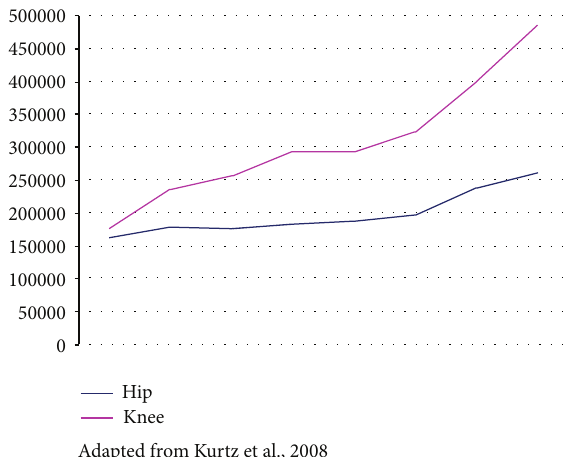
Figure 1: Evolution of the numbers of hip and knee prostheses implanted in the USA between 1990 and 2004.